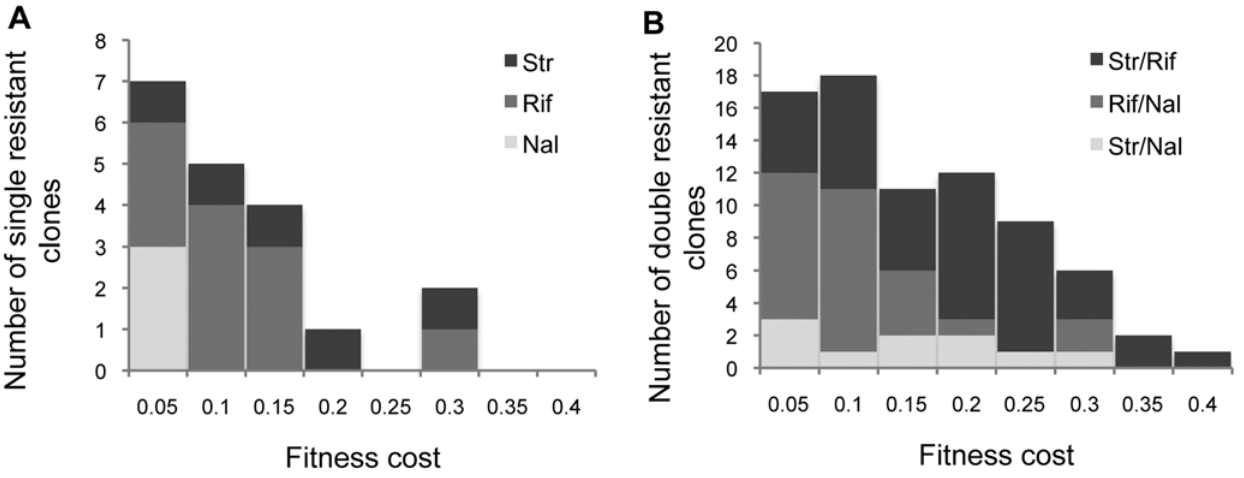
Figure 1. Distribution of fitness costs of single and double mutants indicative of positive epistasis. (A) Distribution of fitness costs of clones carrying single point mutations that confer resistance to streptomycin (black), rifampicin (dark grey) and nalidixic acid (light grey). (B) Distribution of fitness costs of clones carrying double resistance to streptomycin/rifampicin (black), rifampicin/nalidixic acid (dark grey) and streptomycin/nalidixic acid (light grey). The mean fitness cost of double resistants is less than twice the mean cost of single resistance mutations.